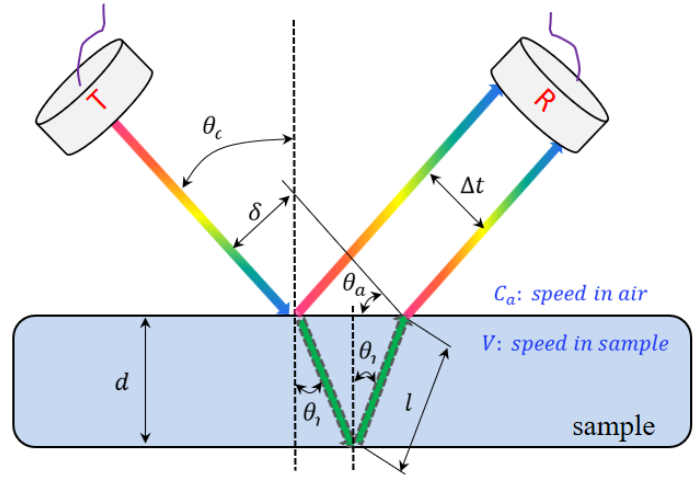
Figure 1. Schematic setup of the direction of a T-ray under reflection mode.